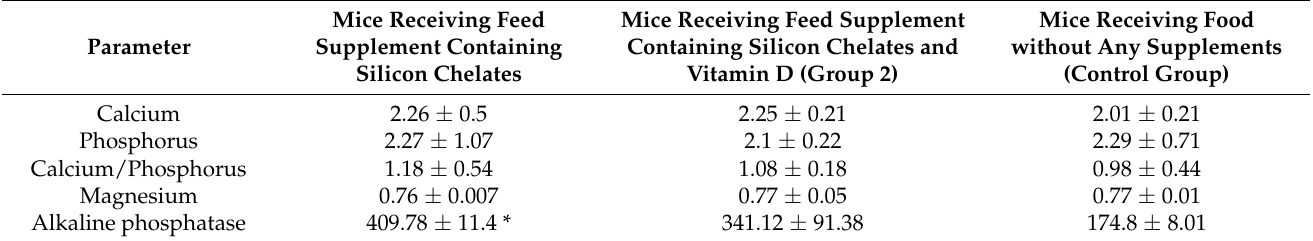
Table 6. Biochemistry parameters of blood serum samples from ICR mice receiving feed supplements containing chelated silicon and vitamin D upon physiological bone